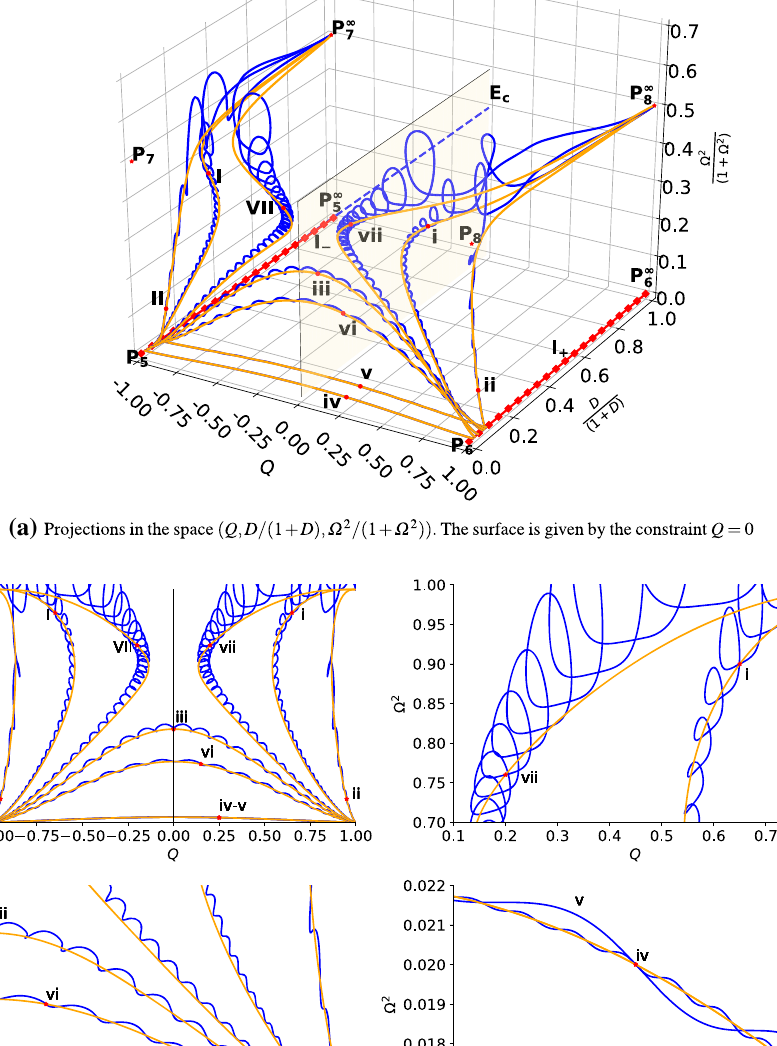
Fig. 21 Some solutions of the full system (118) (blue) and time-averaged system (145) (orange) for the FLRW metric with positive curvature ( k = + 1) when γ = 0. We have used for both systems the initial data sets presented in Table